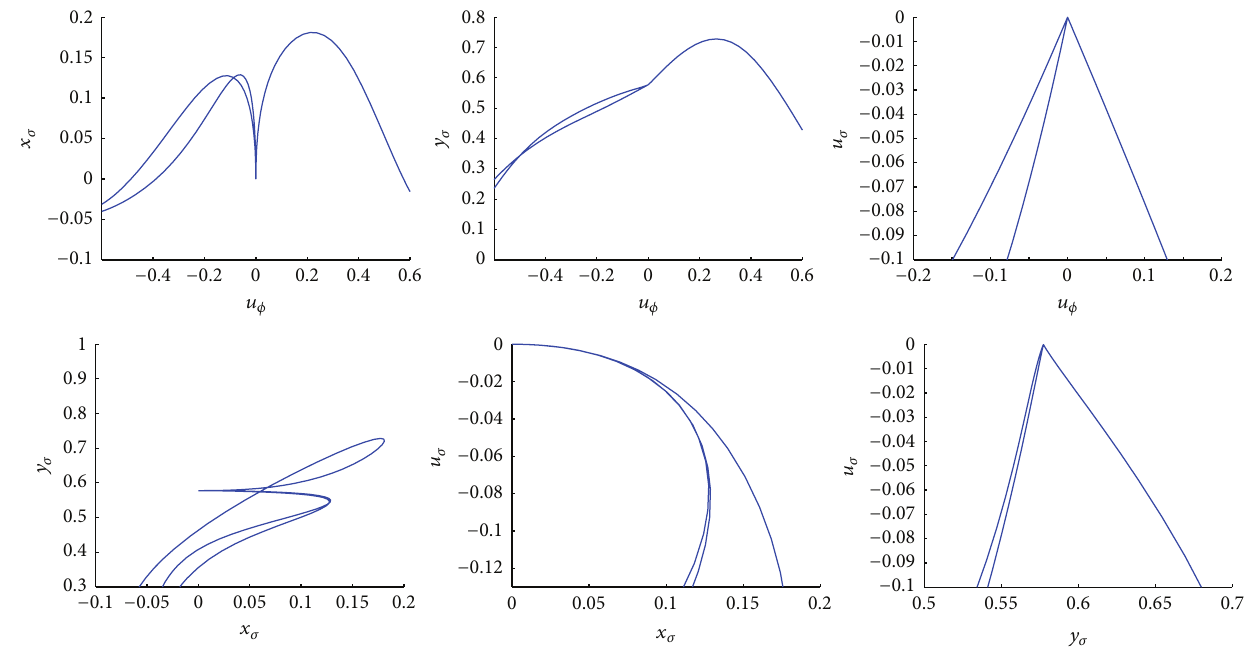
Figure 3: Two-dimensional projections of the phase-space trajectories for 𝜉 1 = 𝜉 2 = 𝜉 3 = −0.5 , 𝛼 𝜓 = 𝛼 𝜙 = 𝛼 𝜎 = −1.5 . All plots begin from the critical point 𝐶 being a stable attractor.